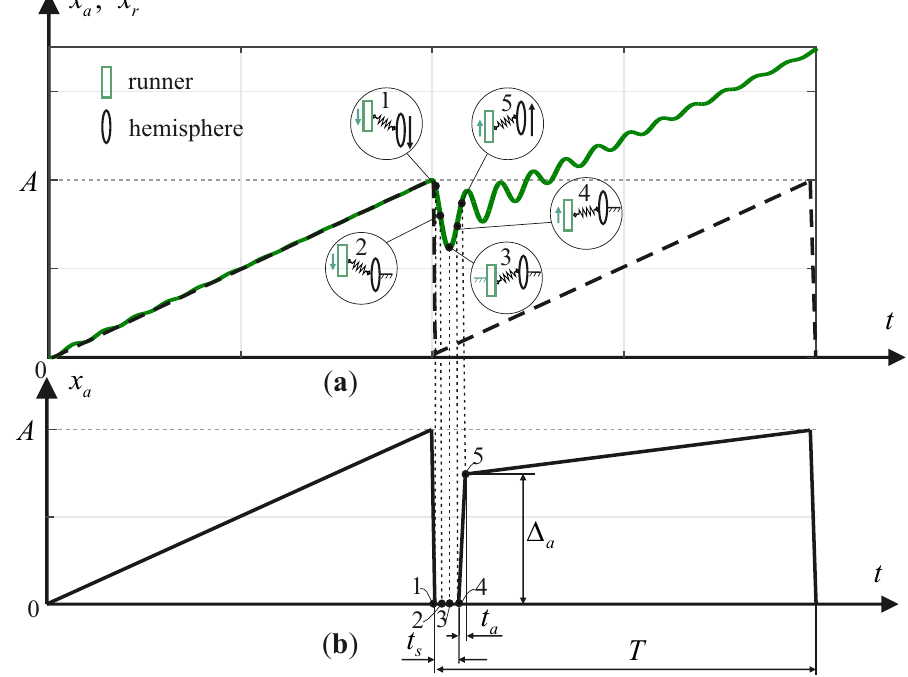
Figure 8. Optimization of the driving waveform: ( a ) standard saw-tooth-like signal (dashed, black line), response of the runner (continuous, green line) and contact status in circles; ( b ) optimized